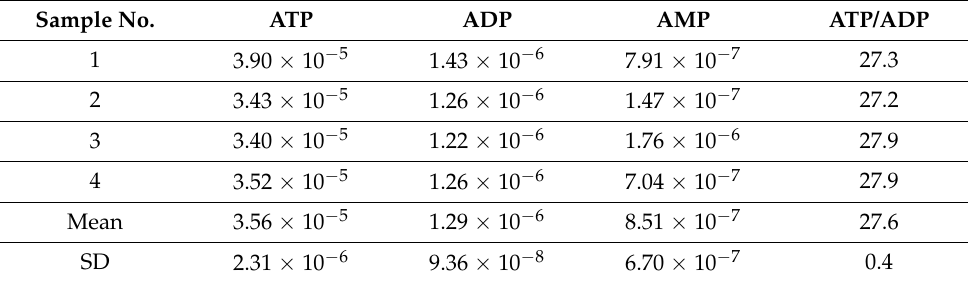
Table 3. Determination of ATP, ADP, AMP in NHBE cells ( µ mol/ µ g protein). Sample